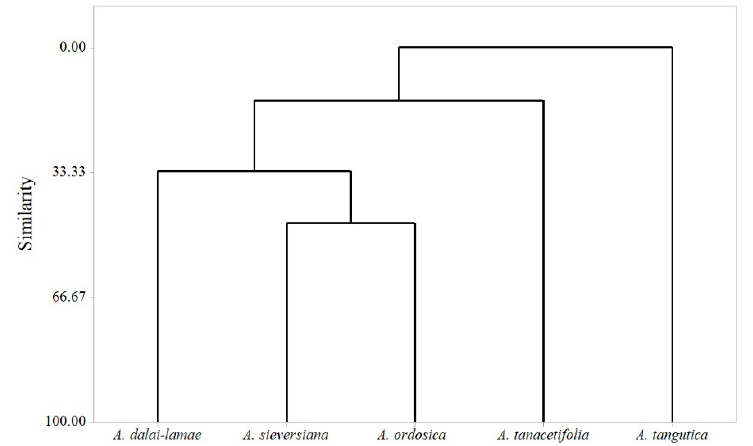
Figure 2. Dendrogram analysis based on essential oil components of five Artemisia species.